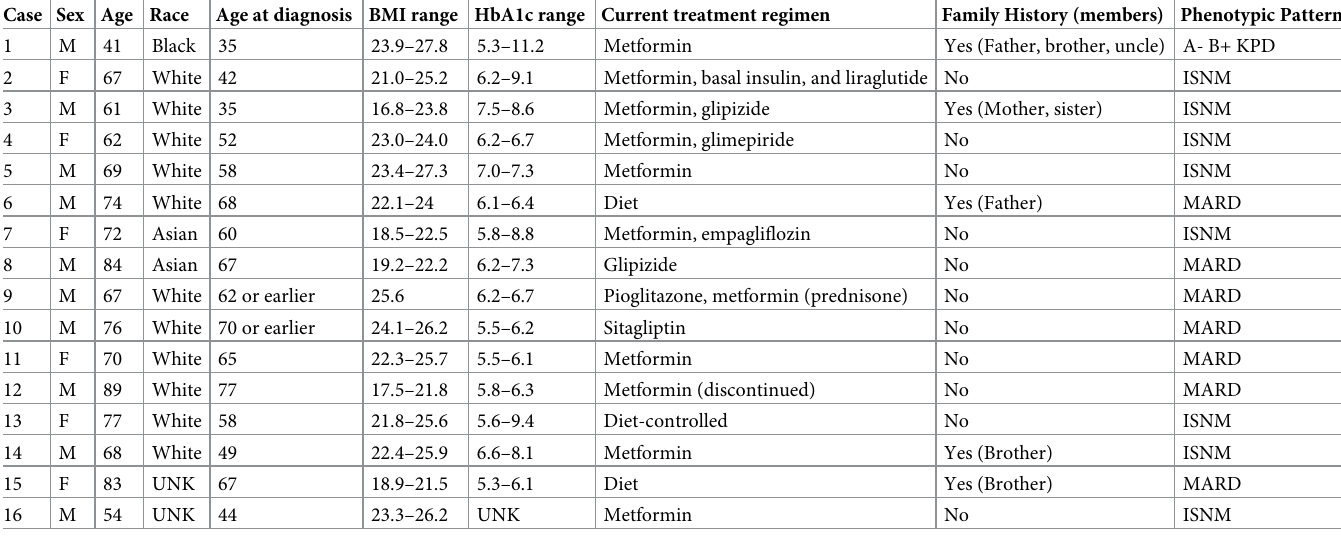
Table 2. Demographic and phenotypic characteristics of individuals with atypical diabetes. Case Sex Age